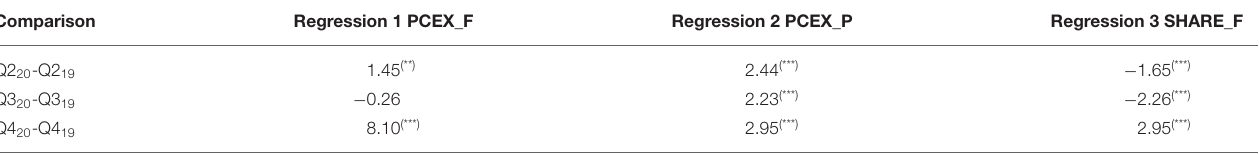
TABLE 7 | Differences in estimated coefficients of seasonal effects before and after